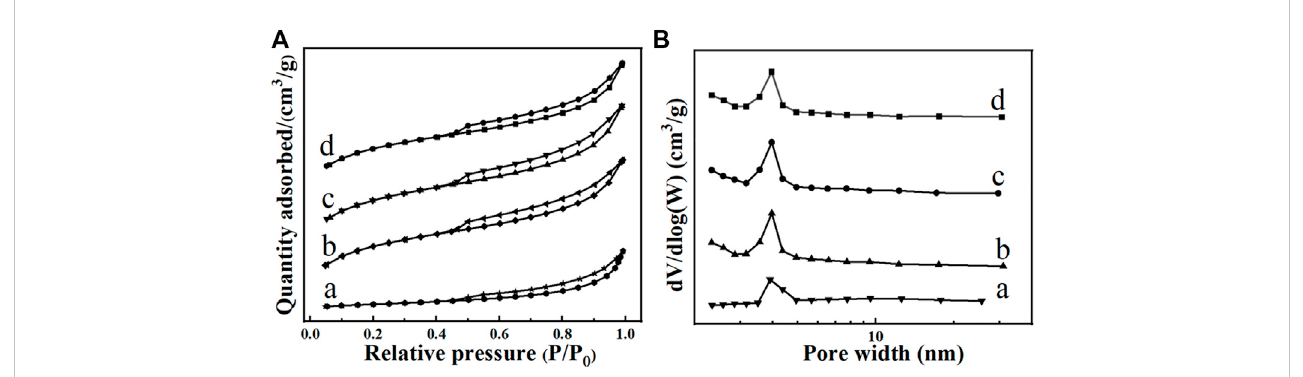
FIGURE 5 N 2 adsorption-desorptionisotherms (A) andcorrespondingporesizedistributions (B) ofthetypicalactivatedcarbonsamples:(A)Fresh,(B)5M-H 2 O 2 -90, (C) 10M-HNO 3 -25, (D) 10M-HNO 3 -90.